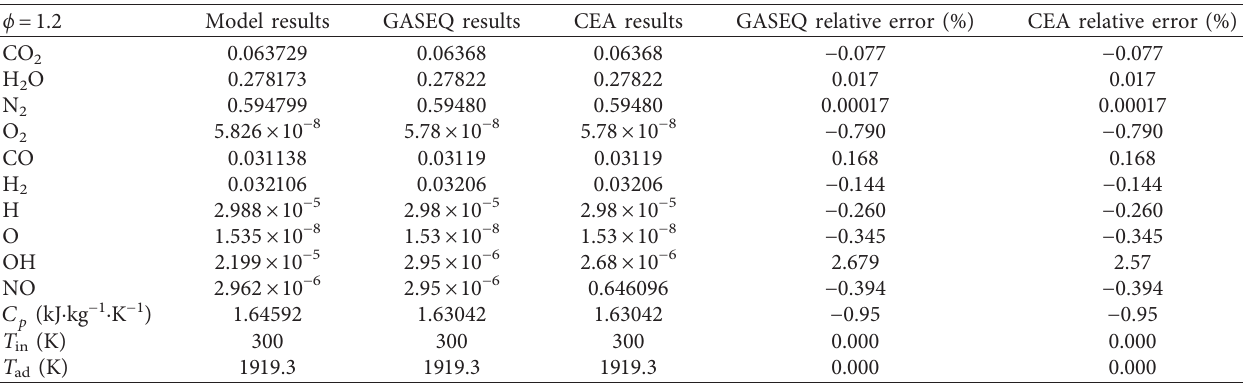
Table 6: Comparison of the present model results with the ones obtained from CEA of NASA and GASEQ software for equilibrium combustion products of methane at ϕ � 1.2 and steam injection